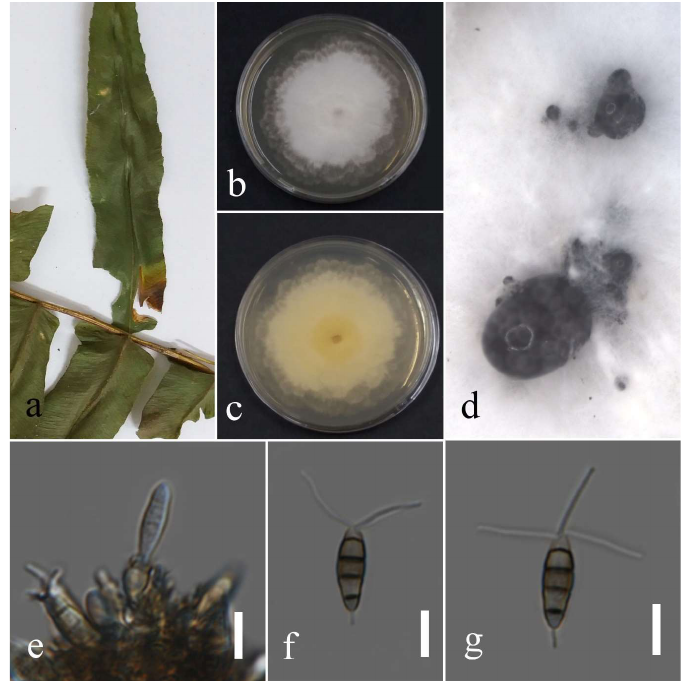
Figure 6. Morphology of Neopestalotiopsis guajavicola (MFLUCC 22 - 0134): ( a ) blight on Nephrolepis sp.; ( b , c ) upper and reverse views of the culture after seven days of growth on PDA at 28 °C; ( d ) conidiomata; ( e ) conidiogenous cells; ( f , g ) conidia . Scale bars = 10 µm .